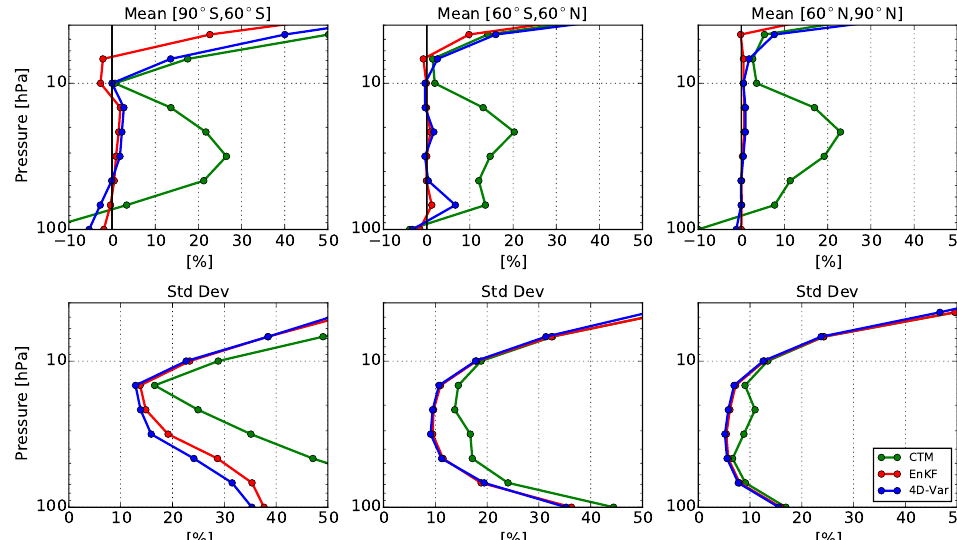
Figure 6. HNO 3 OmF bias (top) and standard deviation (bottom) computed for CTM (green), EnKF (red) and 4D-Var (blue). OmF statistics are computed in percent with respect to the assimilated EOS Aura-MLS data for the period September–October 2008 and for three latitude bands (from left to right: South Pole, tropics–middle latitudes and North